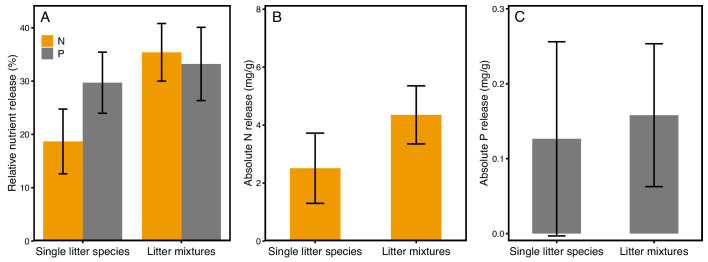
Nitrogen and P release from single litter species treatments and litter mixtures across all studies included in our meta-analysis. The left panel shows relative amounts compared to the initial quantity of N and P (A), and the middle and right panels show absolute amounts of N (B) and P (C).